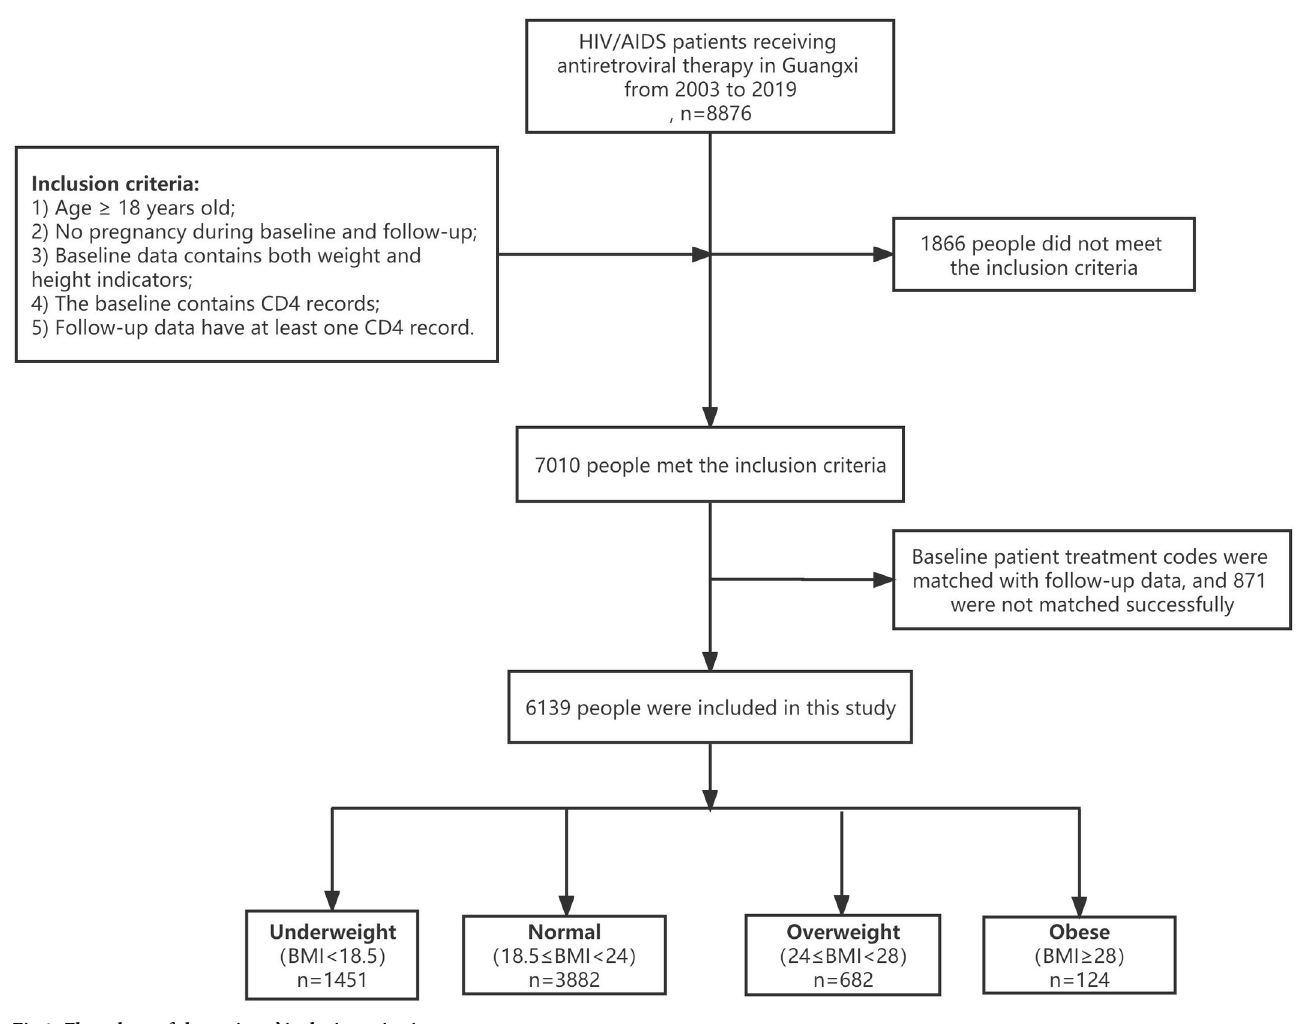
Fig 1. Flow chart of the patients’ inclusion criteria.